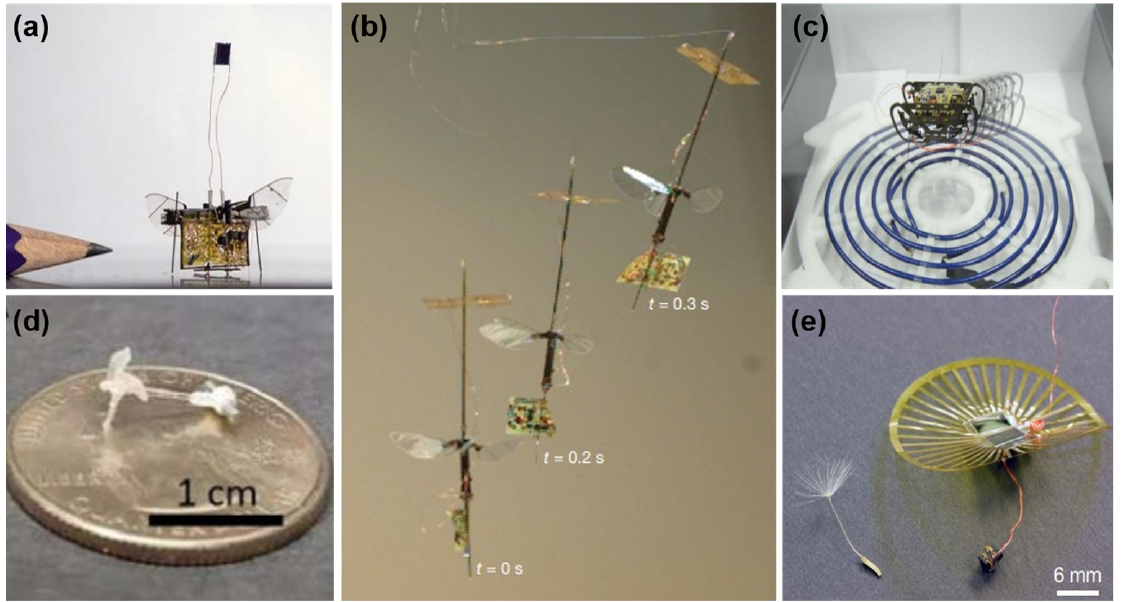
Figure 7. ( a ) Laser-powered insect scale aerial vehicle. Reprinted with permission from Ref. [68]. Copyright 2018, IEEE. ( b ) Untethered flight of flapping-wing MAV. Reprinted with permission from Ref. [53]. Copyright 2019, Springer. ( c ) Wireless-powered HAMR. Reprinted with permission from Ref. [69]. Copyright 2014, IEEE. ( d ) Magnetically driven micro-swimming prototype. Reprinted with permission from Ref. [56]. Copyright 2021, IEEE. ( e ) Wireless wind-dispersed device. Reprinted with permission from Ref. [72]. Copyright 2022, Springer.